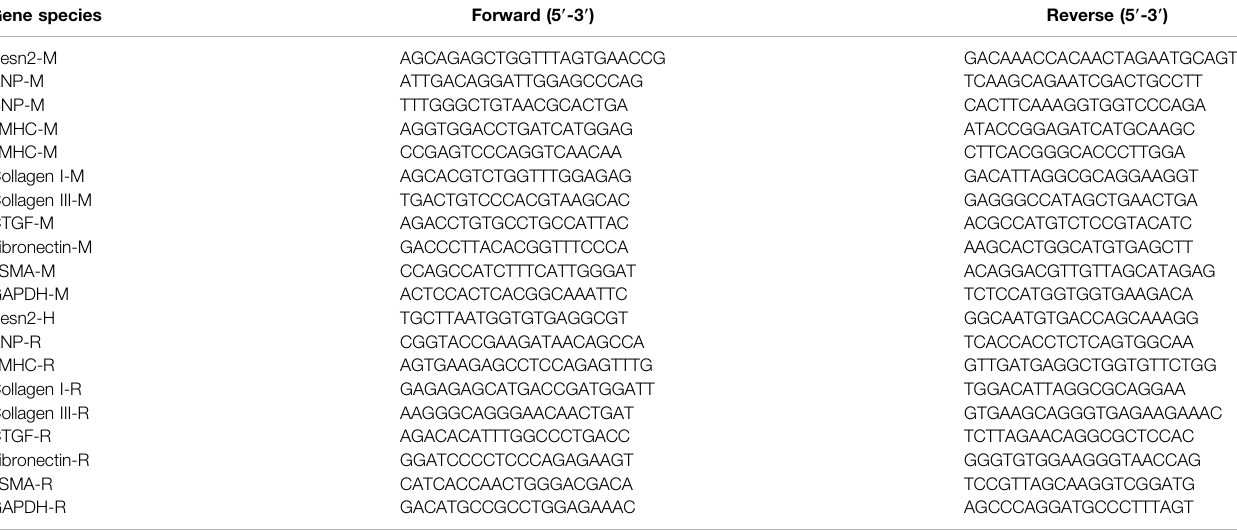
TABLE 1 | Sequences for the primers used in the qRT-PCR experiments. Gene